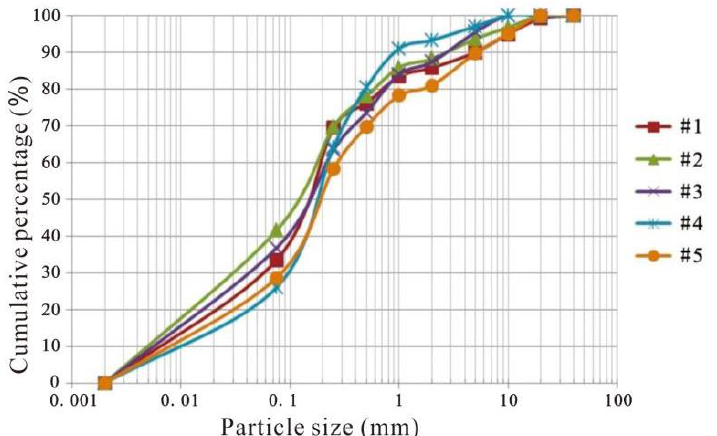
Figure 6. Grain size distribution curves. The different lines represent the different soil samples, as specified in Table 2. Table 3. Calculation parameters for the numerical